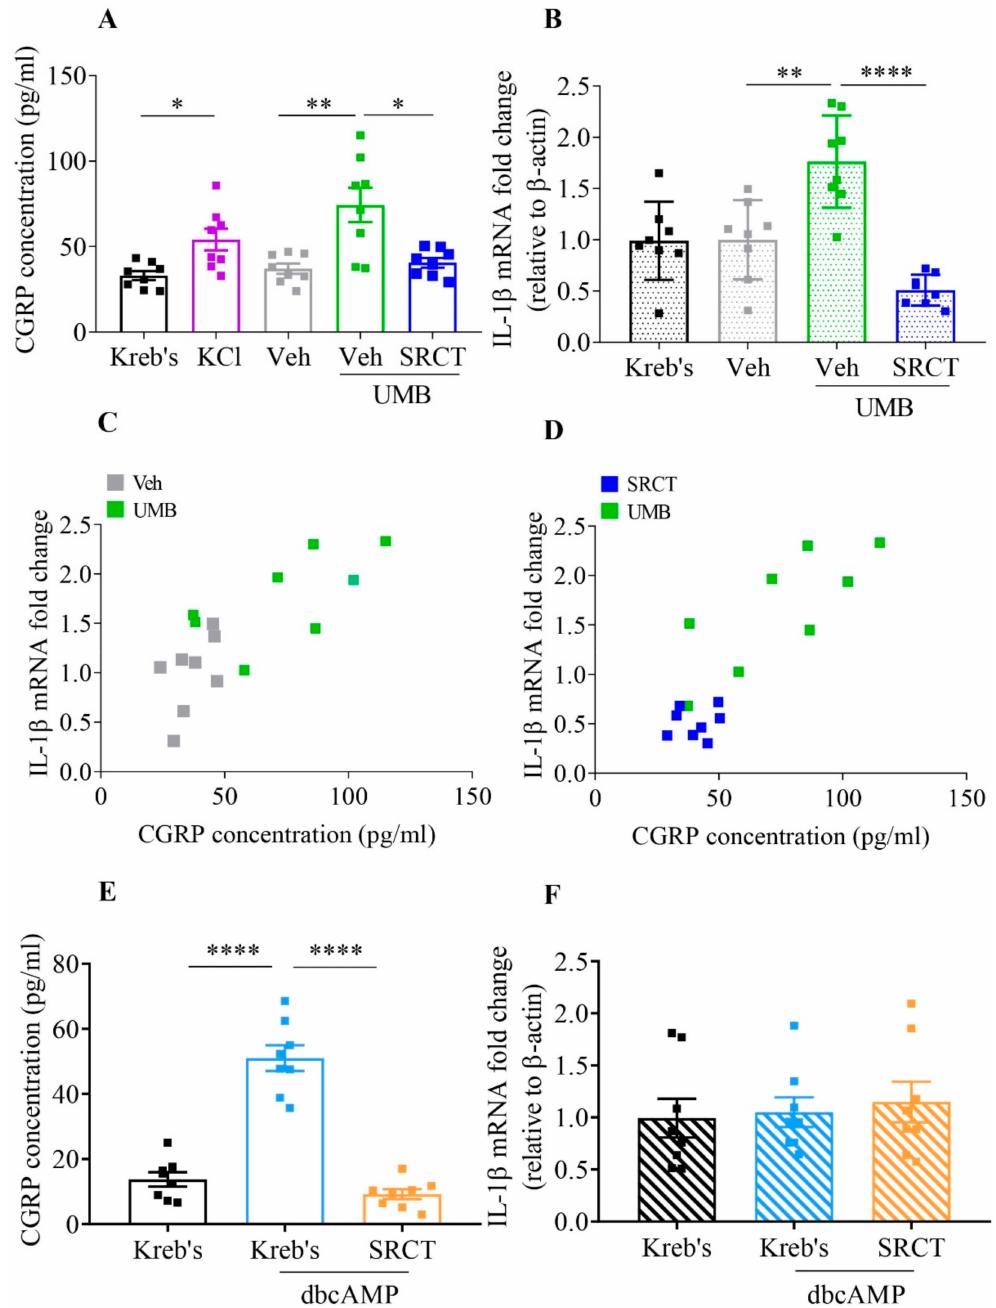
Figure 4. Saracatinib, the SFKs inhibitor, reduced the TRPA1 activator umbellulone-promoted CGRP release and IL-1 β mRNA and the PKA activator dbcAMP-promoted CGRP release in the mouse TG. ( A , B ) Effects of Kreb’s solution, 40 mM KCl, 0.06% DMSO (Veh), 600 µ M umbellulone (UMB) or 600 µ M umbellulone + 1.5 µ M saracatinib (SRCT) on CGRP release (pg/mL) and IL-1 β mRNA fold change relative to β -actin in mouse TG ( n = 8 per group). ( C , D ) Correlation between CGRP release and IL-1 β mRNA fold change in mouse TG treated by 0.06% DMSO, 600 µ M umbellulone or 600 µ M umbellulone + 1.5 µ M saracatinib ( n = 8 per group). ( E , F ) Effects of Kreb’s solution, 300 µ M dbcAMP or 300 µ M dbcAMP + 1.5 µ M saracatinib on CGRP release (pg/mL) and IL-1 β mRNA fold change relative to β -actin in mouse TG ( n = 8 per group). Group data were presented as mean ± SEM. Two-tailed unpaired t-test was used for comparison between Kreb’s and KCl group, vehicle and umbellulone group, vehicle and saracatinib group in the presence of umbellulone, Kreb’s and dbcAMP group, Kreb’s and saracatinib group in the presence of dbcAMP. Two-tailed Pearson correlation was used for correlation analysis between CGRP release and IL-1 β mRNA fold change in each group. Significance differences were shown as * p < 0.05, ** p < 0.01, **** p <